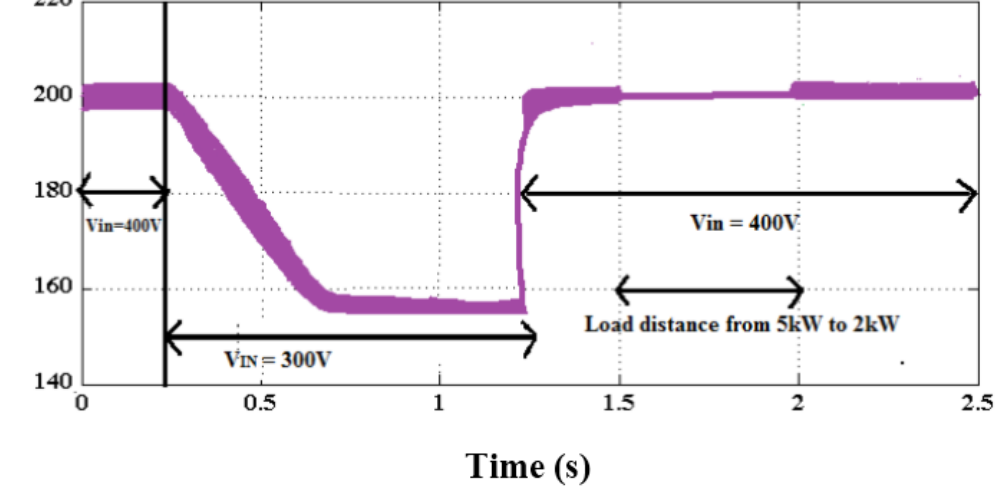
Figure 20. Dynamic performance of inverter.